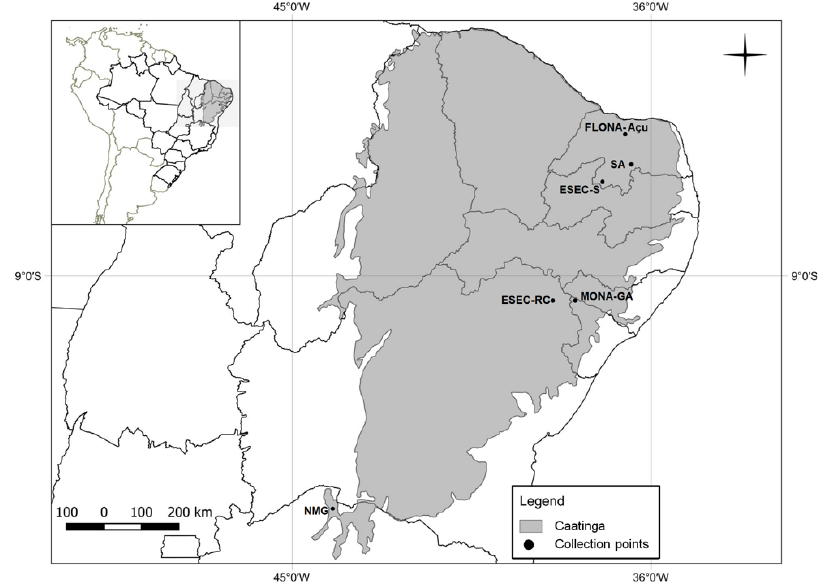
Figure 1. Map of the area covered by the Caatinga biome (grey shading) and the study sites in the states of Bahia (ESEC – RC, Estação Ecológica Raso da Catarina), Minas Gerais (NMG, north of Minas Gerais), Rio Grande do Norte (FLONA – Açu, Floresta Natural do Açu; ESEC – S, Estação Ecológica do Seridó and